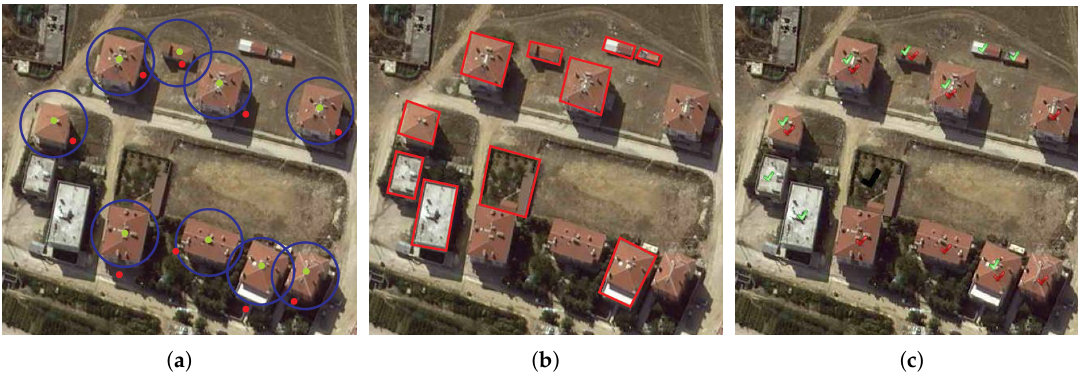
Figure 7. Figure 7a–c show the resultant output of applying TBD, FBD, and results fusion, respectively, on the Ist7 study area.